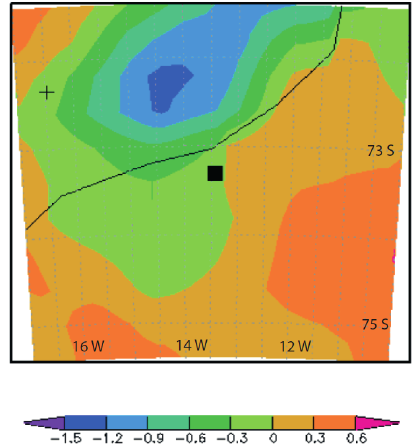
Fig. 10. Difference in 2-m air temperature (in ◦ C), based on the ECMWF operational analyses, between the two measurement cam- paigns (2003/2004–2004/2005) during the Rampen-Basen transect. Basen is marked by the square and Rampen by the